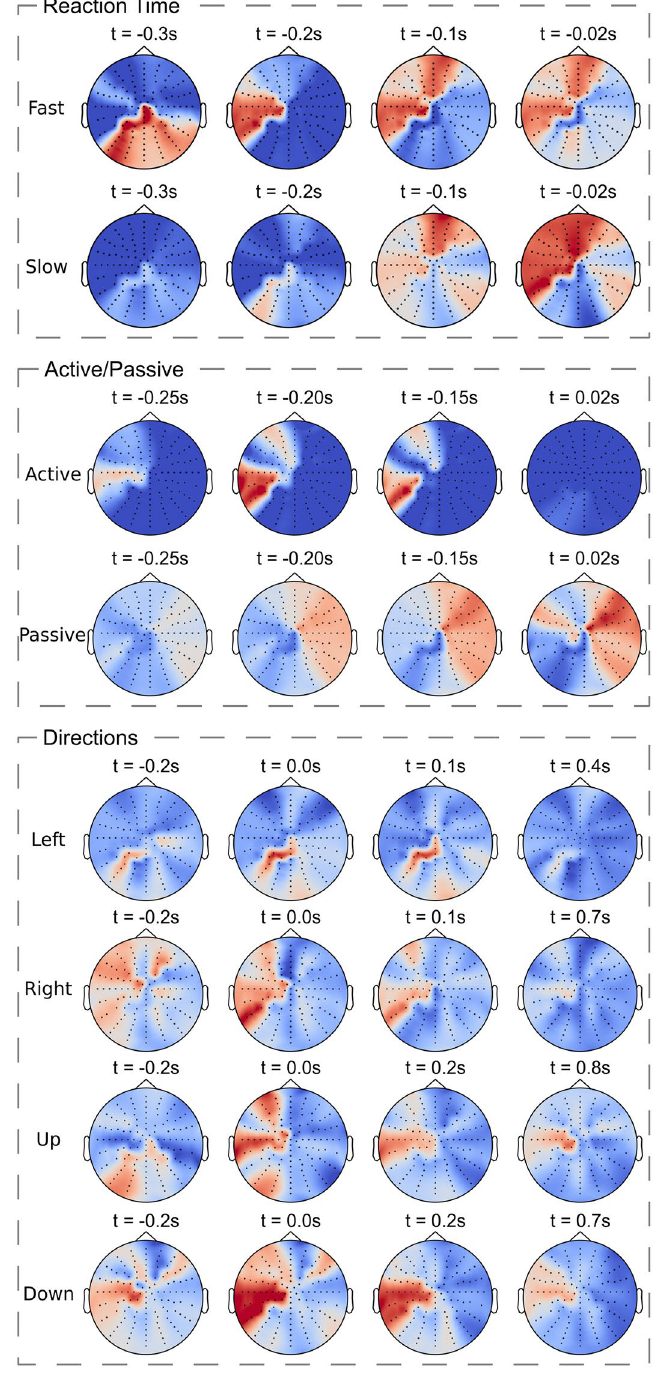
Figure 5. Neurophysiological network interpretation. Gradient-weighted Class activation maps for an individual validation subject for all classification tasks revealed location and timing of activated brain areas. Maps were averaged over all validation trials. The activation maps for all the remaining subjects are provided in the supplementary material (Figs.